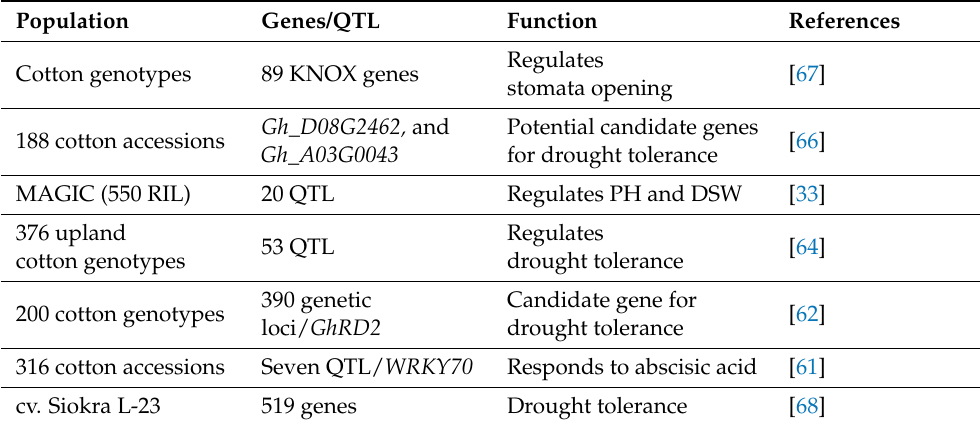
Table 2. GWAS-based identified QTL/SNPs for drought tolerance in